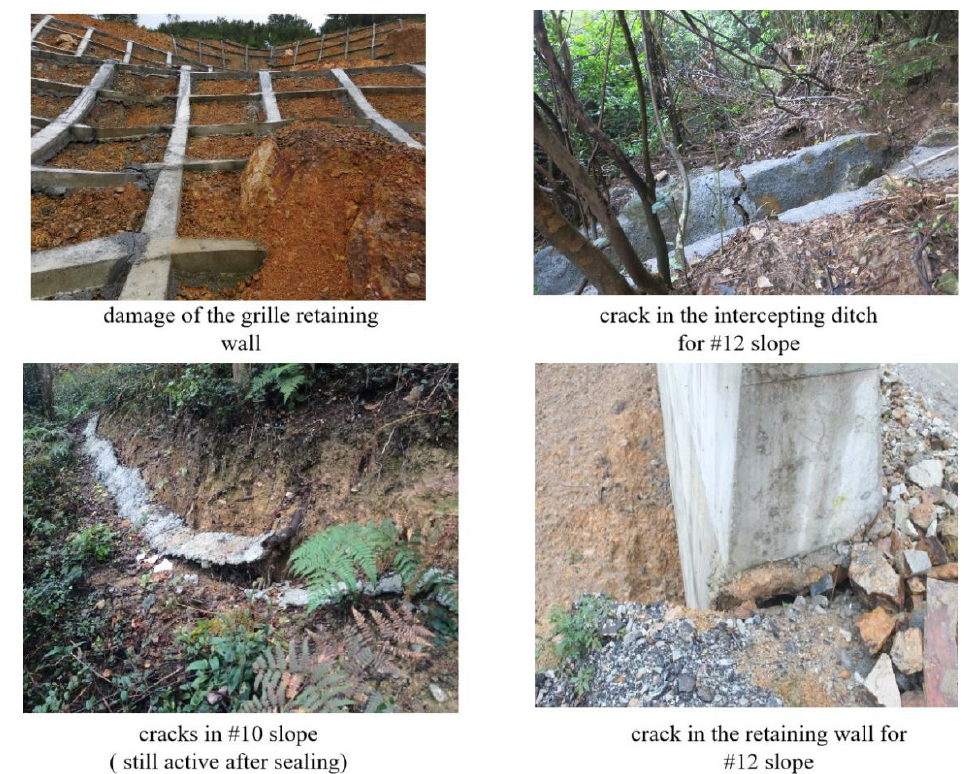
Figure 4. Cracks and deformation in the field.